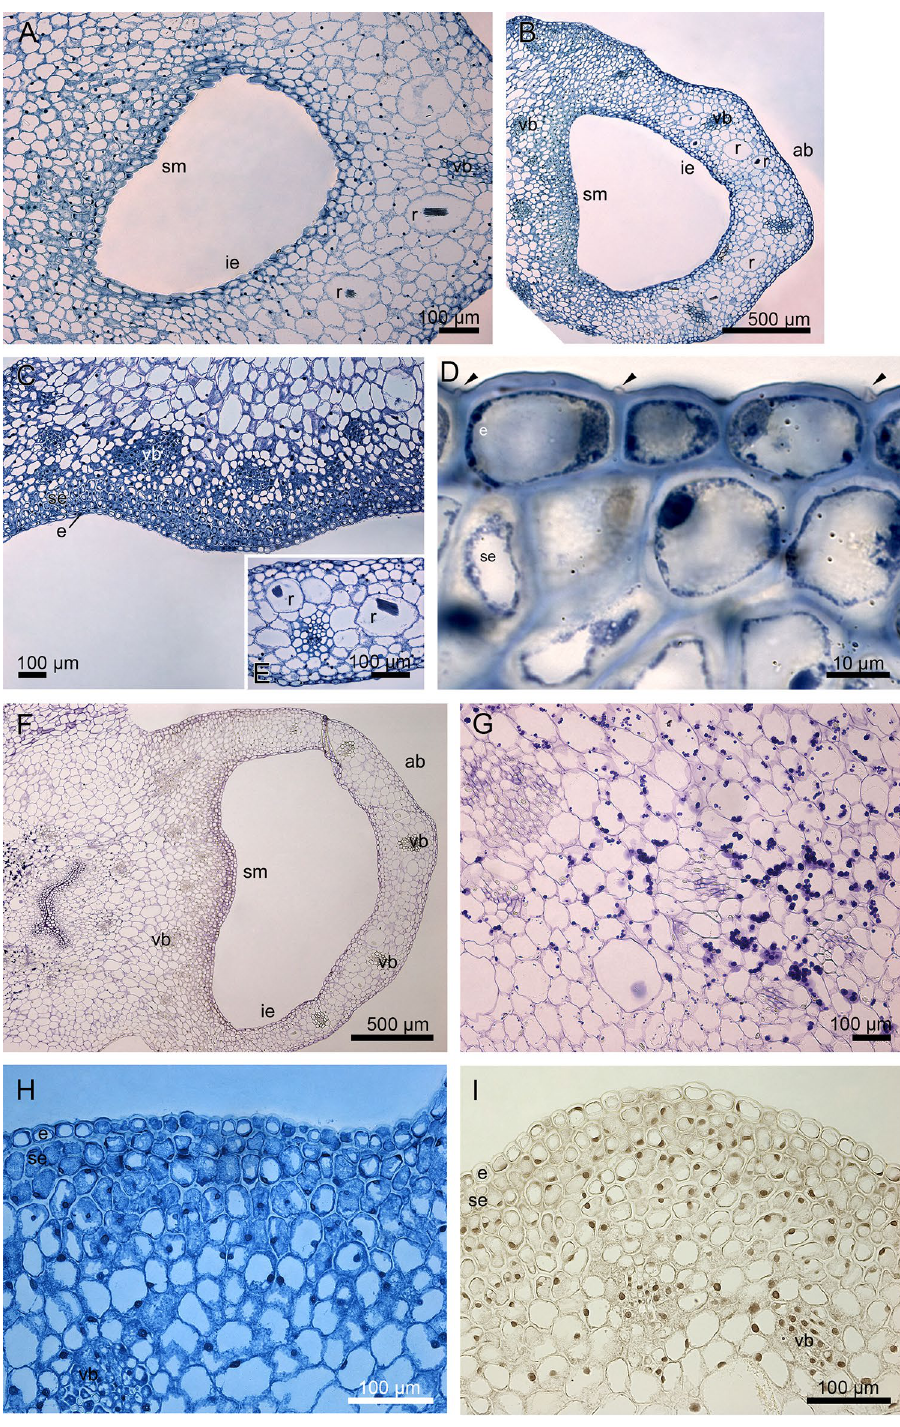
Figure 4. Histochemical tests of the lip and the swollen mound of gynostemium: ( A – C ) The transverse sections from the saccate lip base and the swollen mound with dense cytoplasm, only exclusively in the swollen mound of gynostemium, the vacuolized parenchyma cells, collateral vascular bundles (TBO); ( D ) The cuticular swellings noticeable on epidermal cells of the mound (TBO; arrows ); ( E ) The idioblasts with bundles of raphides—sharp needle-like crystals of calcium oxalate (TBO); ( F , G ) the starch grains in deeper layers of parenchyma, not in epidermis (PAS); ( H ) The test for presence of proteins of a swollen mound (ABB); ( I ) The test for presence of dihydroxyphenols of a swollen mound with no detection (FeCl 3 ). ab —abaxial (outer) side; e —epidermis; ie —inner epidermis, inside the saccate lip base; r —idioblast with raphide crystals; se — subepidermis; sm —a swollen mound; vb —vascular